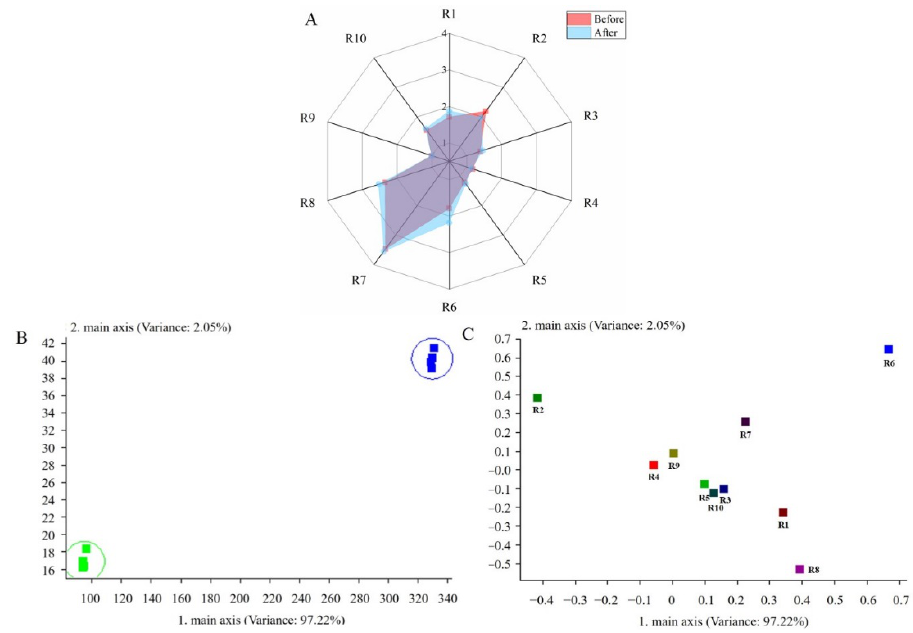
Figure 5. Radar plot ( A ), PCA score plot ( B ), and loading plot ( C ) of the aromatic compounds in the R–B mixed juice before and after fermentation detected by electronic nose.